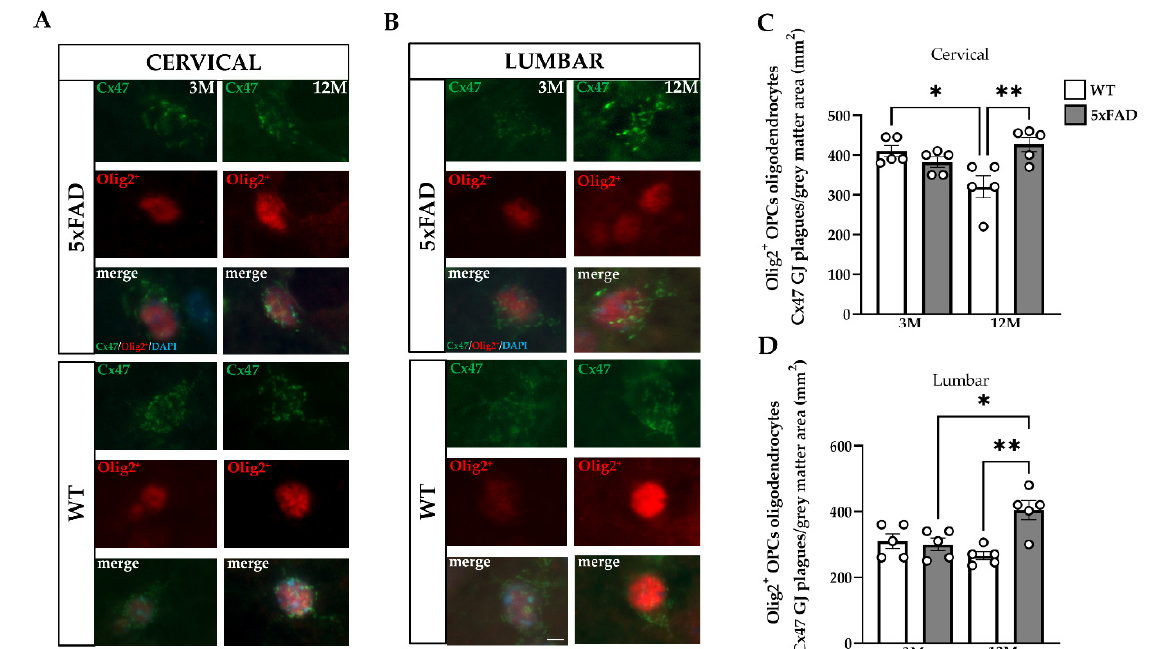
Figure 8. Elevation of oligodendrocyte precursor cells (OPCs) expressing Cx47 within the GM of the 5xFAD spinal cord. Double immunofluorescence staining was performed ( A ) in cervical C3 and ( B ) lumbar L3 spinal cord segments from 5xFAD and WT mice using a marker for oligodendrocyte precursors (OPCs), Olig2 (red), and anti-Cx47 antibody (green). Cell nuclei were counterstained with DAPI (blue). Quantification of the mean number of Olig2 + precursors ( C , D ) expressing Cx47- positive GJ plaques in the GM of 5xFAD and WT mice of all ages showed increased numbers of Olig2 + OPCs in 12M 5xFAD mice in both spinal cord sections in comparison with their WT litterma- tes. The statistical analysis was performed by one-way ANOVA followed by Kruskal–Wallis multi- ple comparisons test ( n = 6 for all genotype and age groups). Data are presented as mean ± SD. ( A , B ) Scale bars = 10 µm. Significance is given as: * p < 0.05, ** p < 0.01.